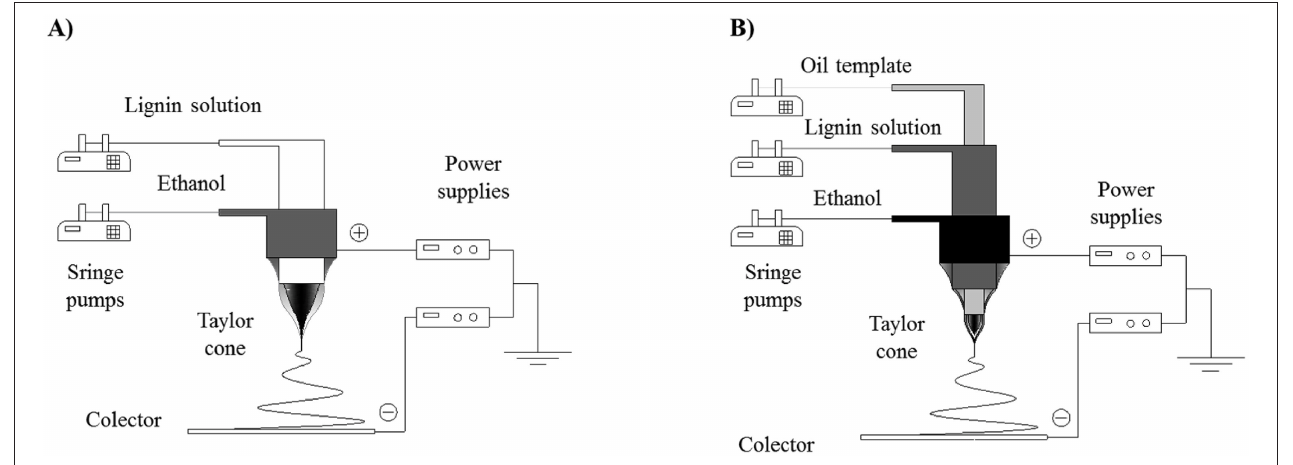
FIGURE 2 | Scheme of (A) co-axial and (B) tri-axial electrospinning for preparing lignin solid fibers and tubes, respectively.